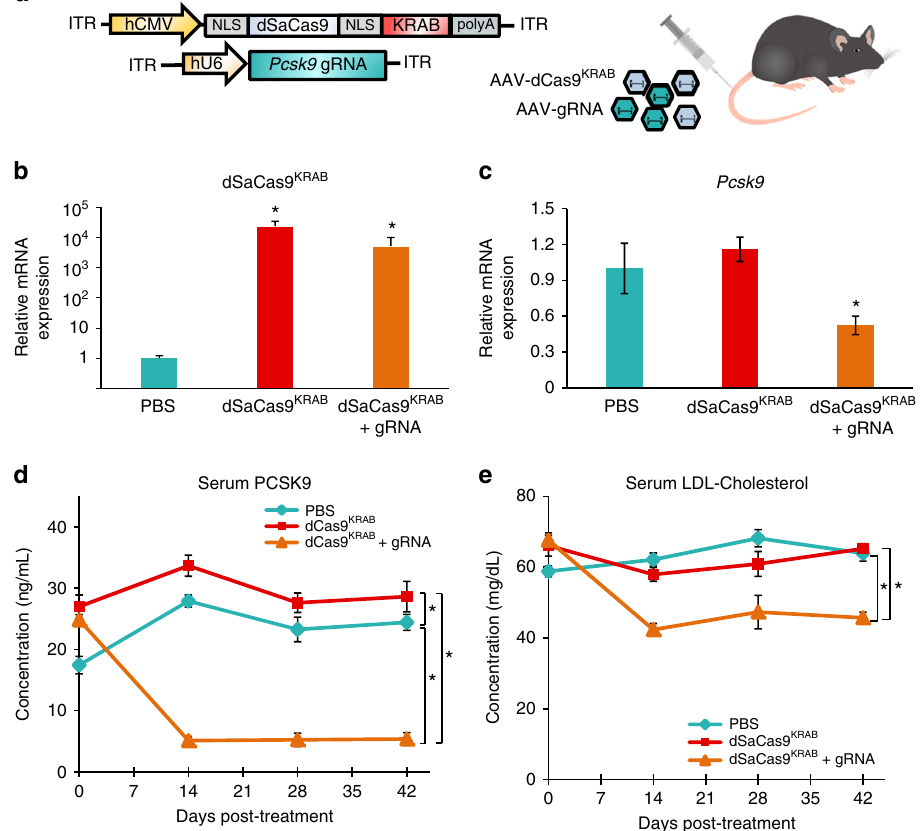
Fig. 2 Targeted gene silencing in adult wild-type mice with S. aureus dCas9 KRAB . a A dual AAV vector system was designed to deliver dSaCas9 KRAB and Pcsk9-targeting gRNA to adult-wild type mice via tail-vein injection. qRT-PCR for b dSaCas9 KRAB and c Pcsk9 expression was performed on mRNA from livers harvested from treated mice at 6 weeks post-injection (mean ± s.e.m, n = 4 mice). P < 0.05 is indicated by *, determined by Student ’ s t- test compared to controls. Serial serum collections were assayed for secreted d Pcsk9 protein levels and e low-density lipoprotein cholesterol (mean ± s.e.m., n = 4 mice, * indicates P < 0.05 by mixed design ANOVA with Tukey ’ s post-hoc